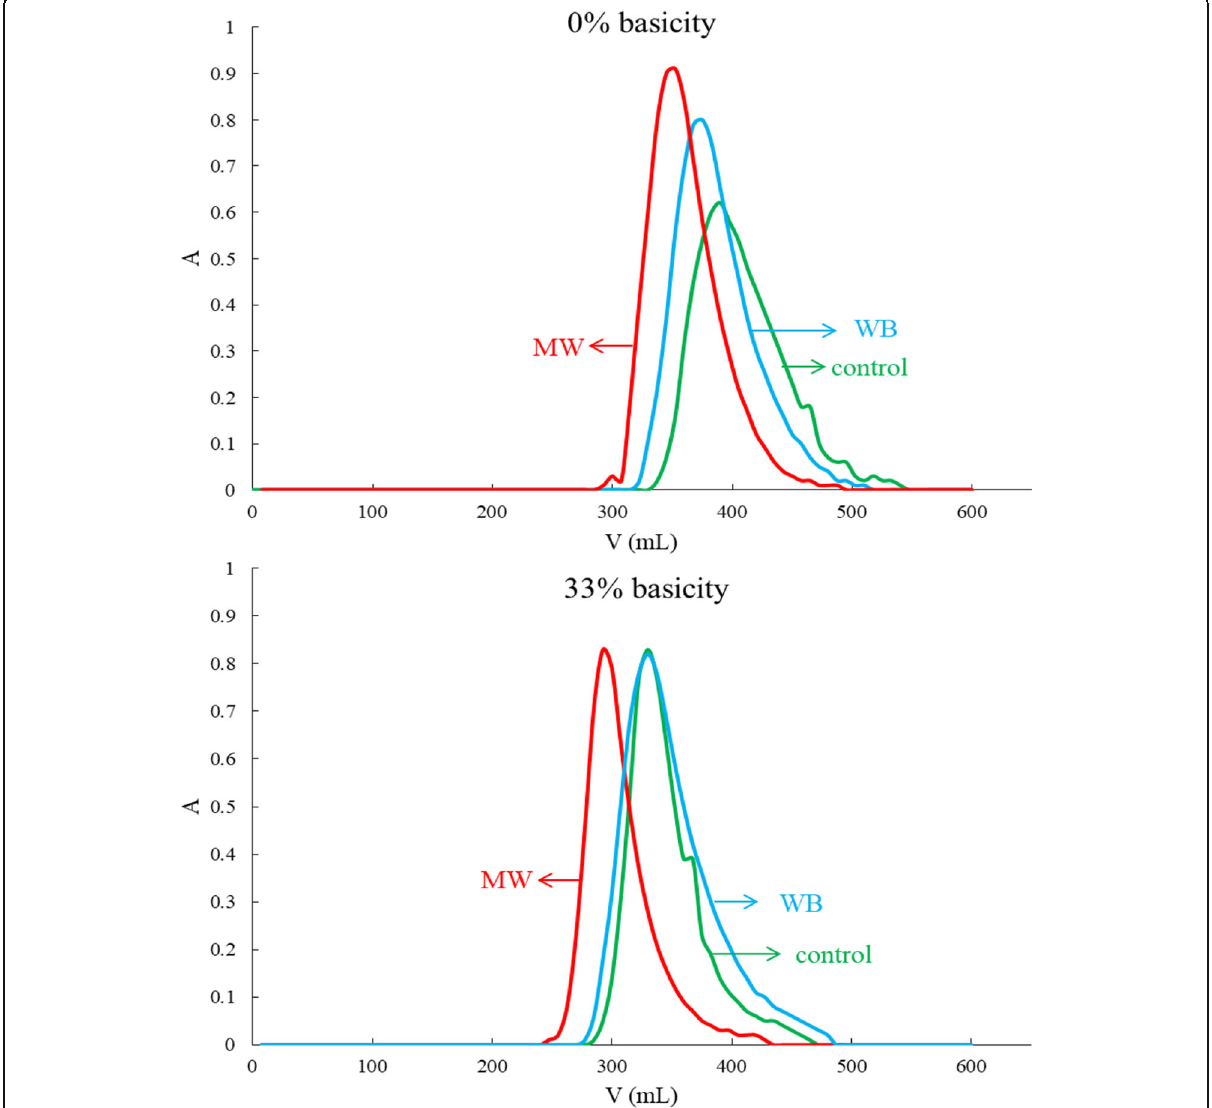
Fig. 3 The GFC results of chromium sulphate tanning liquors warmed under different